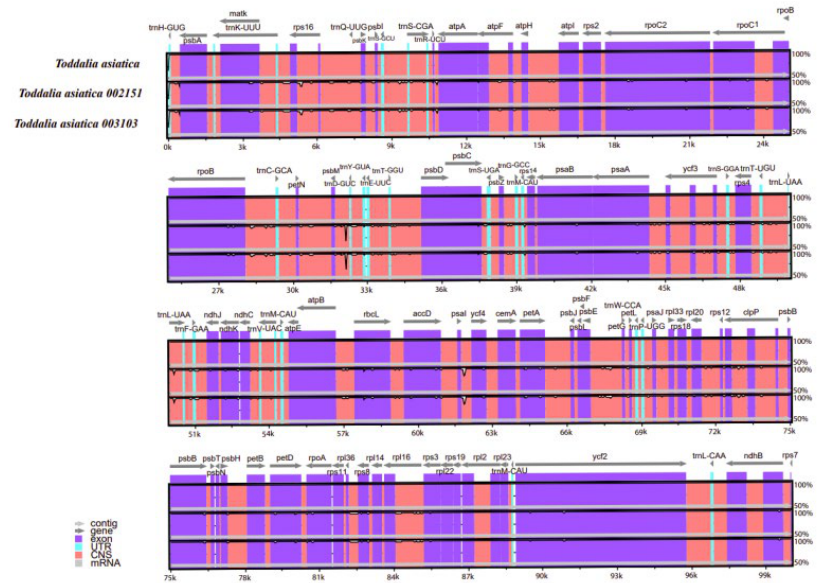
Figure 6. Sequence alignment of plastomes of Toddalia species using the LAGAN method. A cut-off of 70% similarity was used for the plot and the y-scale represents the percent similarity ranging from 50–100%.